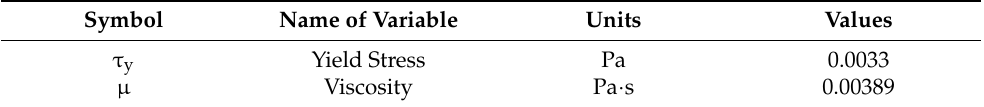
Table 2. Fitted rheological parameters of the Casson model on steady experimental data reported in